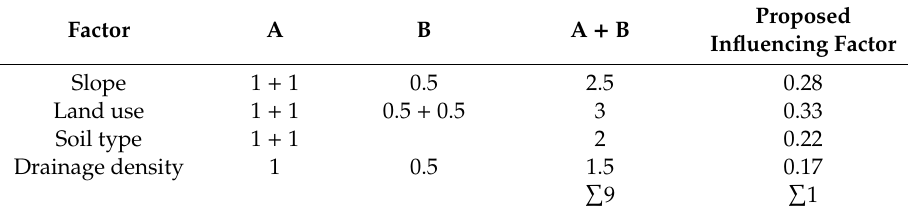
Table 3. Influencing e ff ects by recharge potential